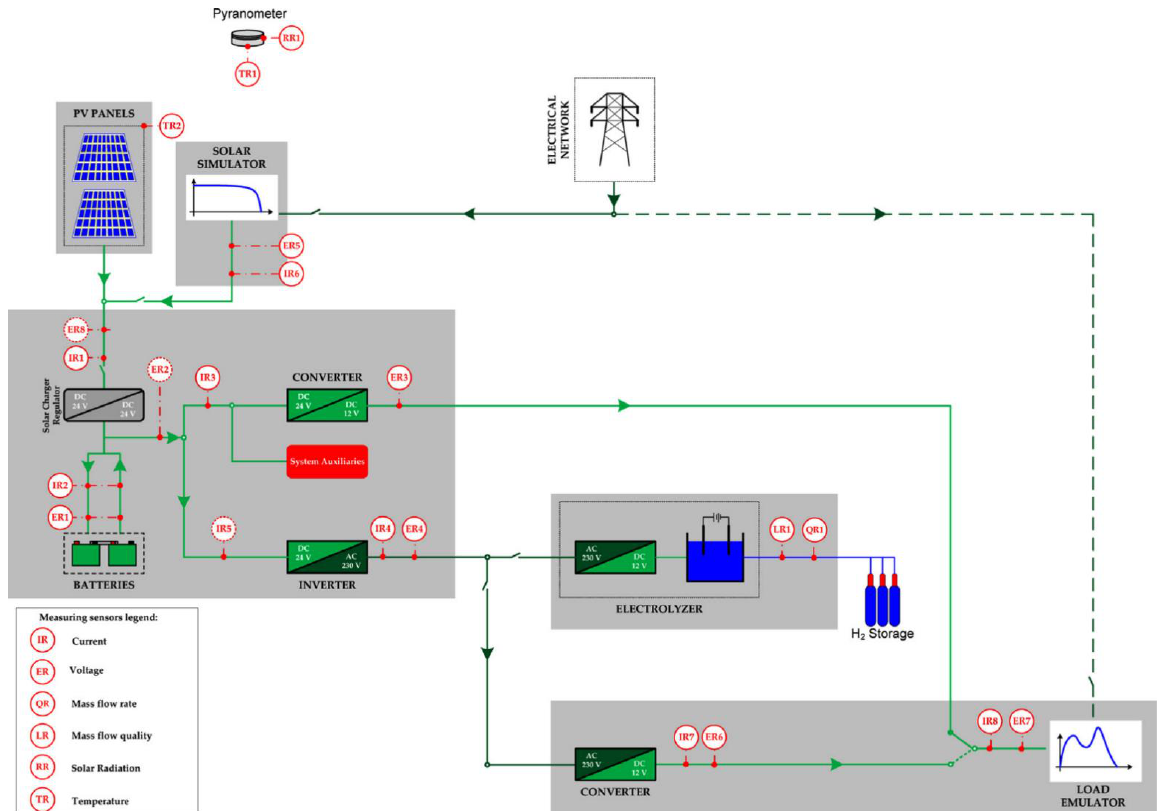
Figure 11. Flow diagram of a hybrid PV-RHFC laboratory nanogrid. Reprinted with permission from Ref. [7]. 2017, Elsevier.